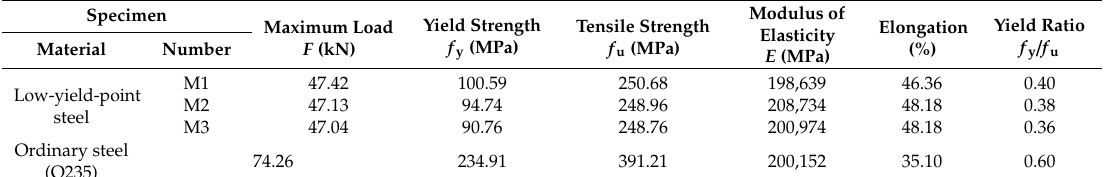
Table 5. Results of the material test.